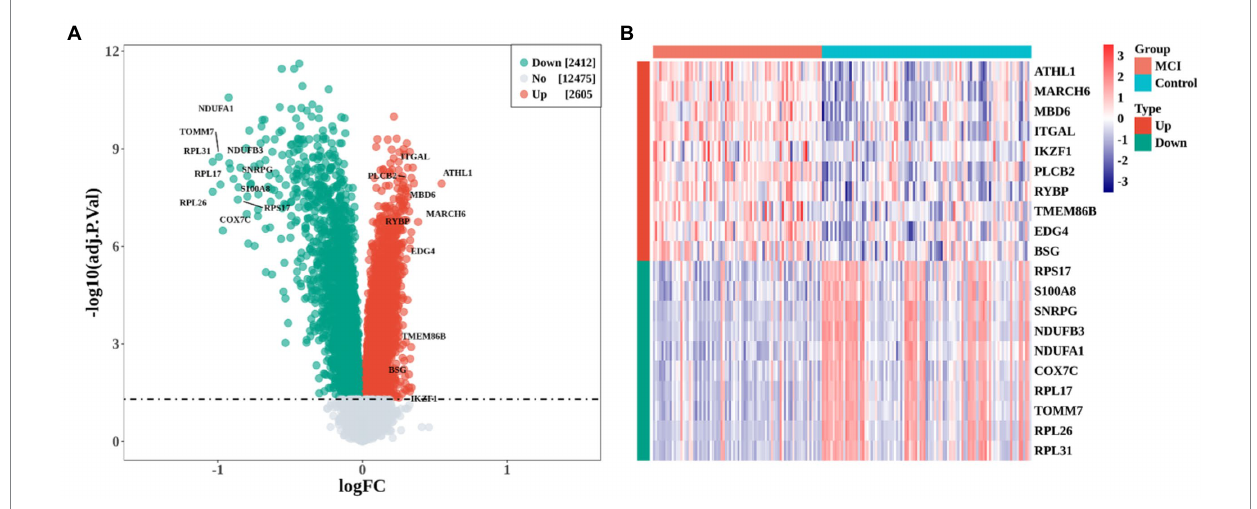
FIGURE 1 Identification of differentially expressed genes (DEGs) between MCI and Control group. (A) Volcano plot of DEGs expression profile. (B) heatmap of the top 10 up-regulated and down-regulated DEGs, respectively.